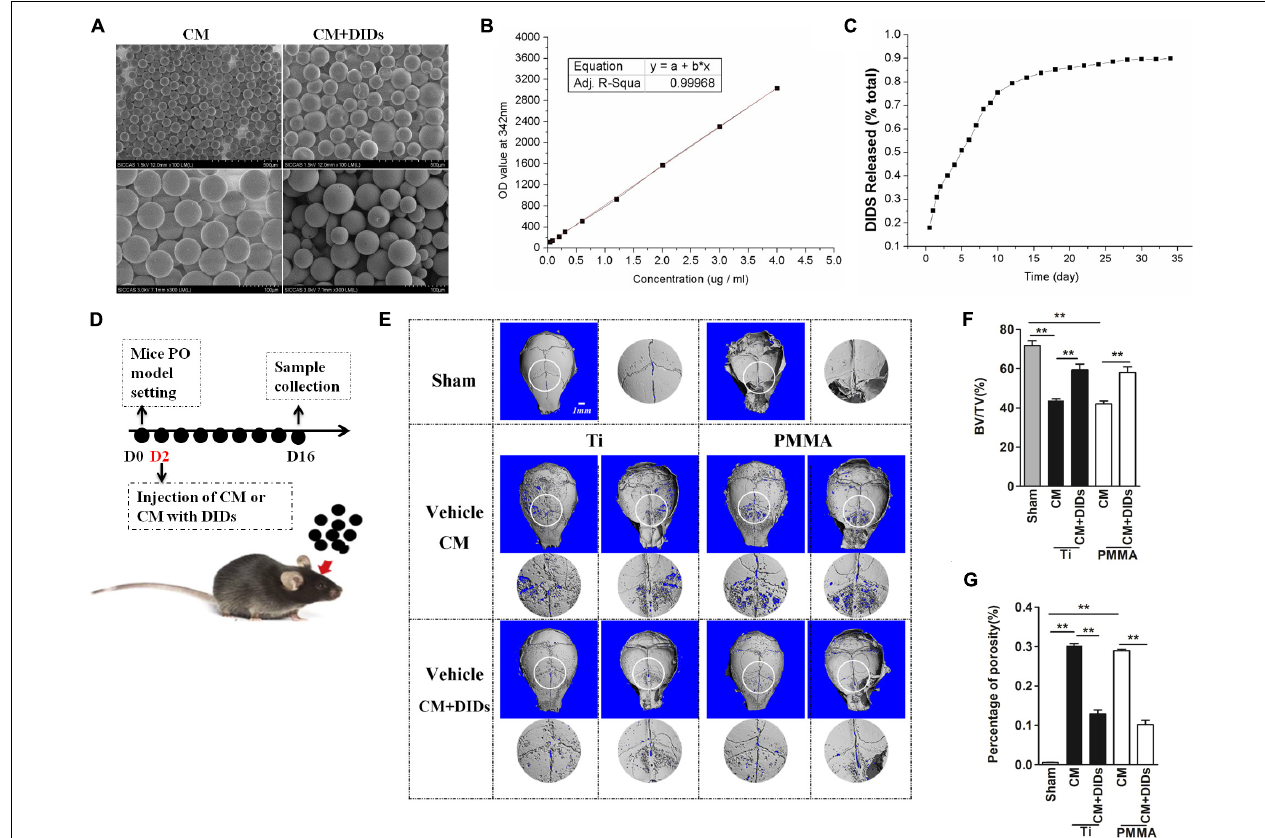
FIGURE 5 | Therapeutic effect of chitosan microspheres (CMs) encapsulating DIDS on mice wear particle-induced osteolysis. (A) Scanning electron micrographs of CMs. (B) Standard curve of DIDS. (C) The control release ability of CMs. (D) Timeline of the experiment. (E) CMs encapsulating DIDS controlled wear particle-induced osteolysis demonstrated by micro-CT. (F) Bone volume against tissue volume (BV/TV), (G) the percentage of total porosity (%) of each sample was measured ( ∗ P < 0.05; ∗∗ P <